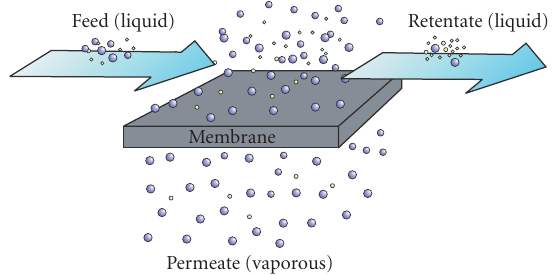
Figure 2: Principles of pervaporation: liquid feed, liquid retentate (depleted), solution-di ff usion membrane, and vaporous permeate (enriched).